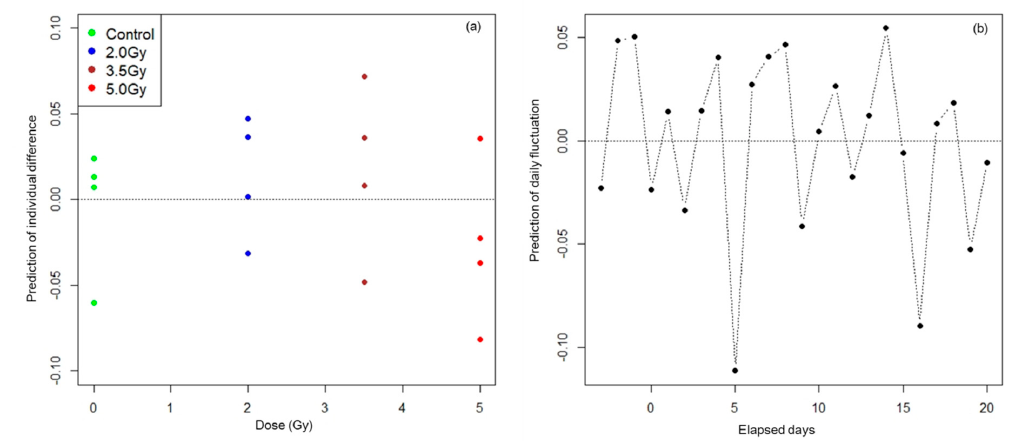
Figure 3. Predictions of random values. Predictions of random values by individual ˆ δ i by group are shown in panel ( a ) and predictions of random values by day ˆ η t are shown in panel ( b ). Residuals in the optimal NLMM and in the optimal NLRM are given by y it − ˆ f ( t (cid:12) (cid:12) and y it − ˆ f ( t (cid:12) D i , θ ) , respectively. The standard deviations of residual errors in the optimal NLMM and optimal NLRM were 0.038 and 0.071, respectively. The distributions of residuals in the NLMM and NLRM are shown in Figure 4.